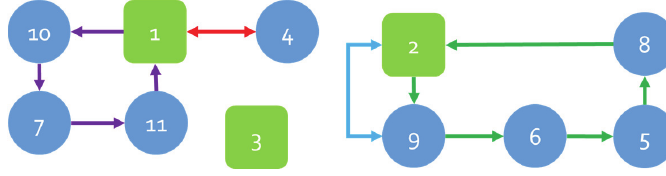
Fig. 2. Distribution route of period